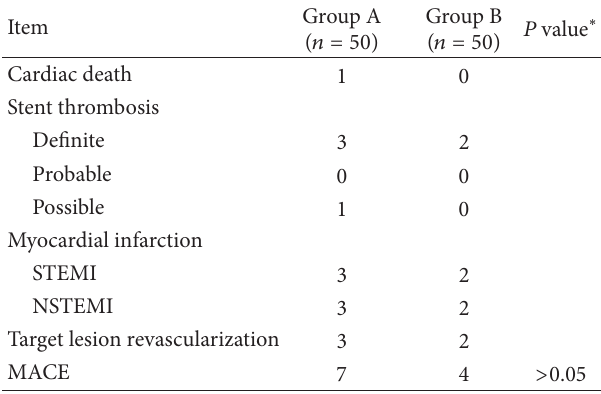
Table 4: Clinical events at 8-month